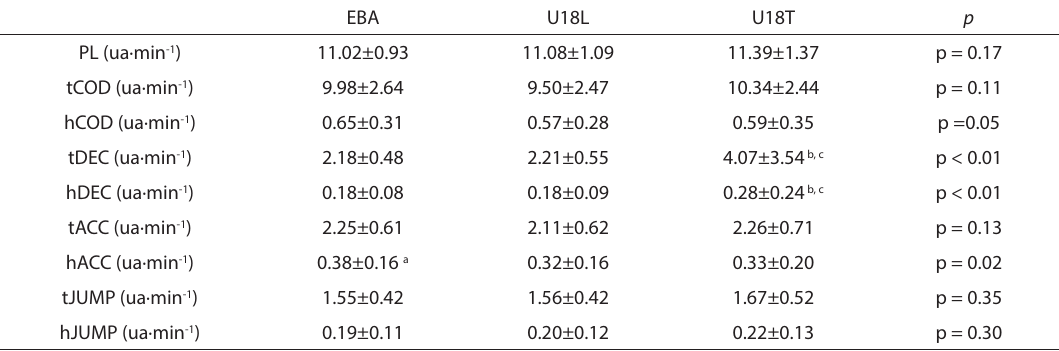
Table 2. Mean ± standard deviation (SD) for each of the external load variables in the three competitions analysed: EBA League (EBA), U18 autonomic league (U18L) and international tournament